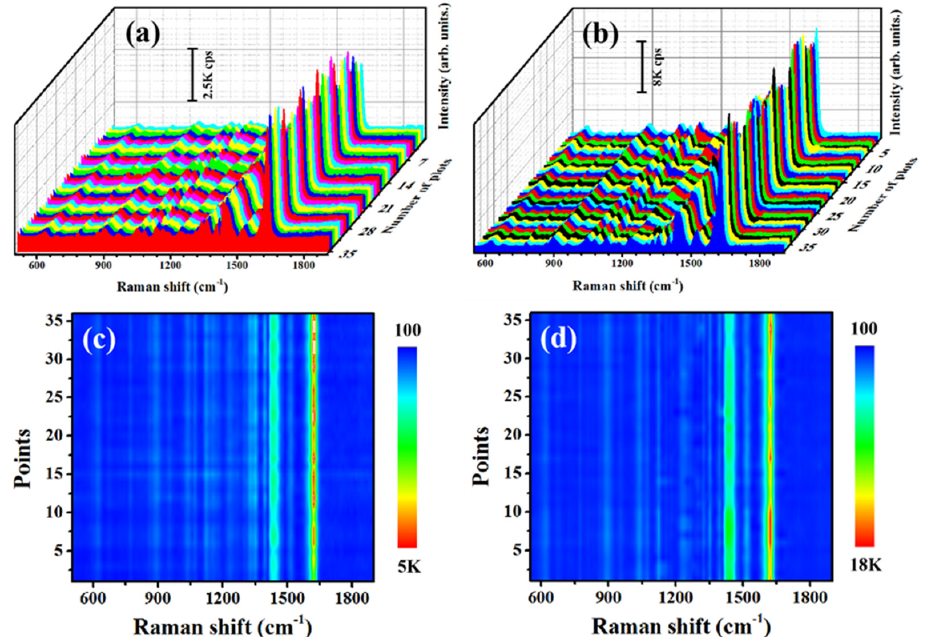
Figure 5. ( a , b ) SERS spectra of the 10 − 5 M MB solution recorded from 36 randomly selected points from the AgCu@MW-20 and Ag@Cu@MW-3 substrates. ( c , d ) The SERS contour plots of 10 − 5 M MB collected from 36 randomly selected points from the AgCu@MW-20 and Ag@Cu@MW-3 substrates.